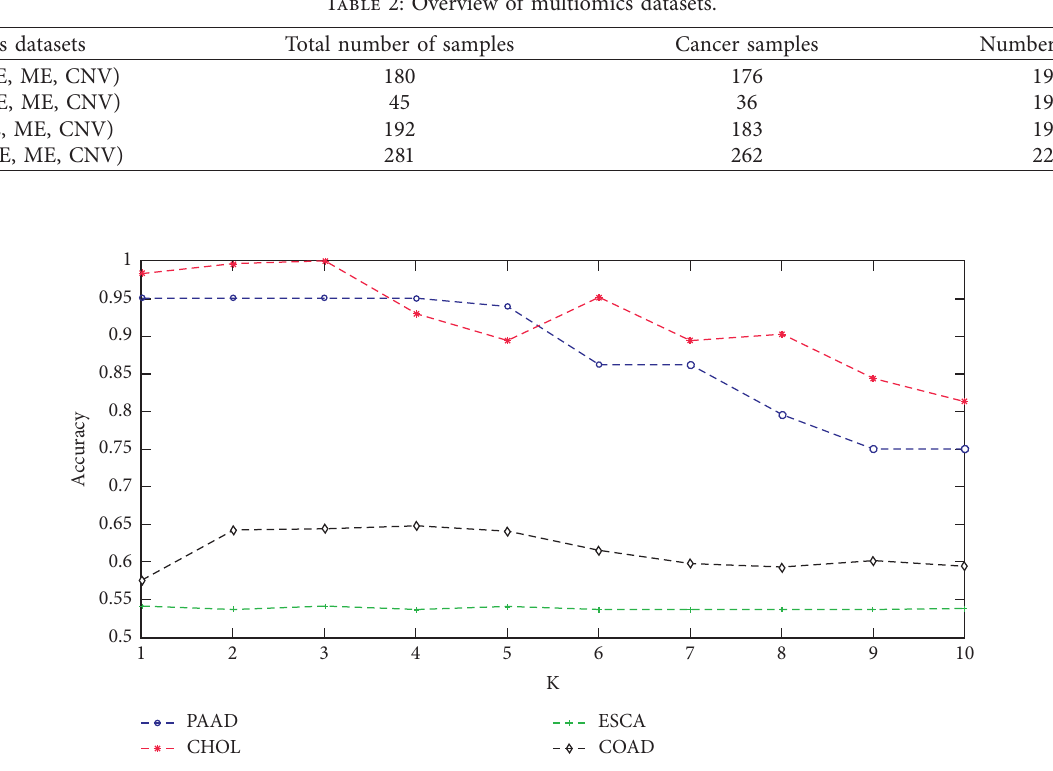
Figure 3: Accuracy of SG-jNMF varies with